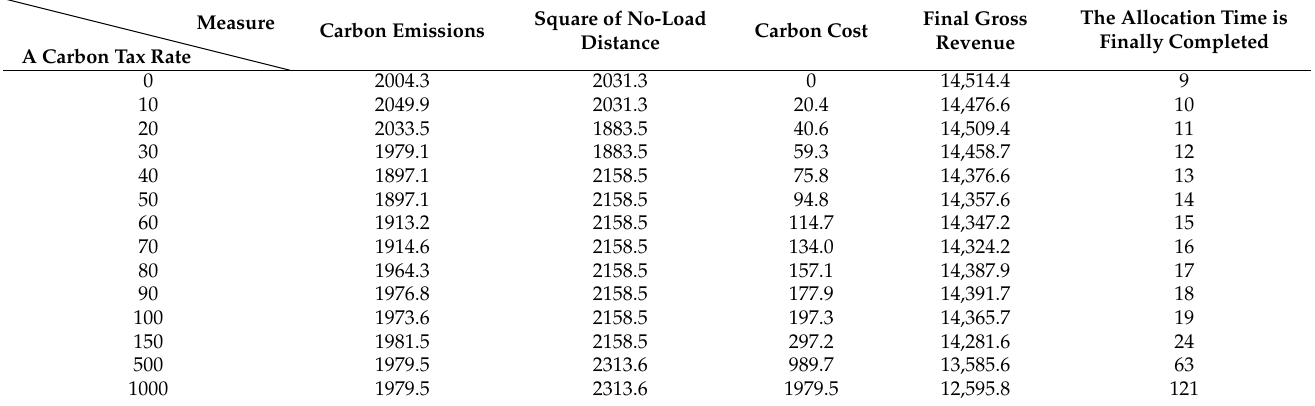
Table 6. Differences of various indicators under the influence of the carbon tax